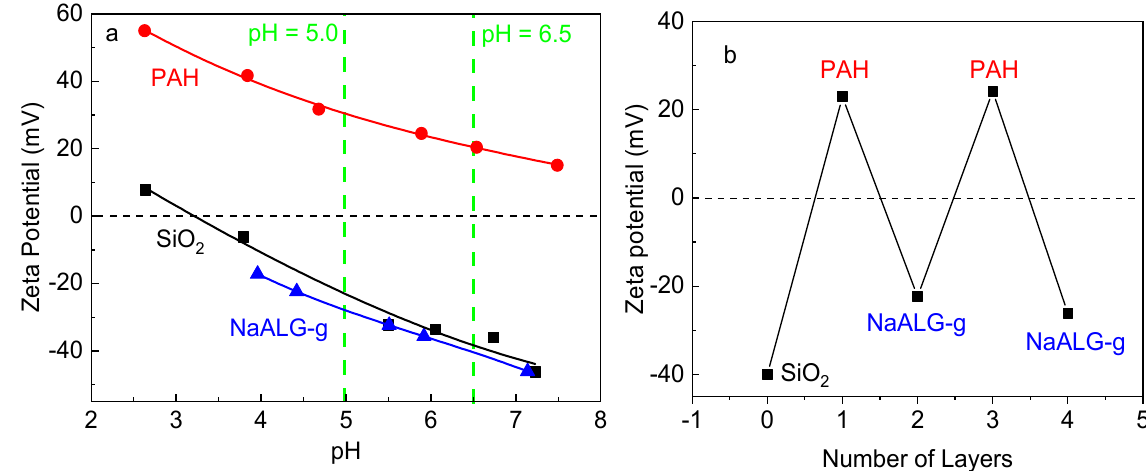
Figure 2. ( a ) pH-dependent zeta potential of bare SiO 2 (black squares), PAH (red circles) and NaALG-g (blue triangles). All sample solutions have a concentration of 3 mg/mL, and the pH was adjusted using HCl 0.1 M or NaOH 0.1 M. ( b ) Evolution of zeta potential during the sequential deposition of the different layers on the surface of silica particles in aqueous solution (3 mg/mL, pH = 6.5).